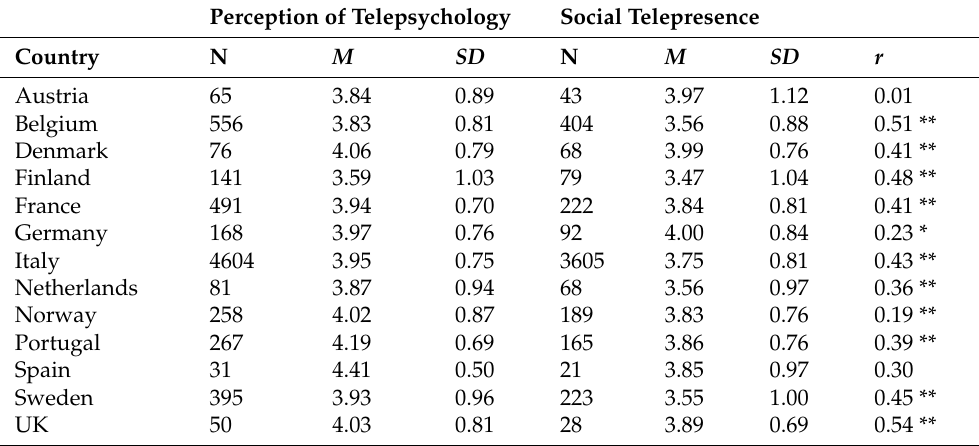
Table 1. Perception of telepsychology and social telepresence as reported by European mental healthcare professionals, and the correlation between these concepts. Perception of Telepsychology Social